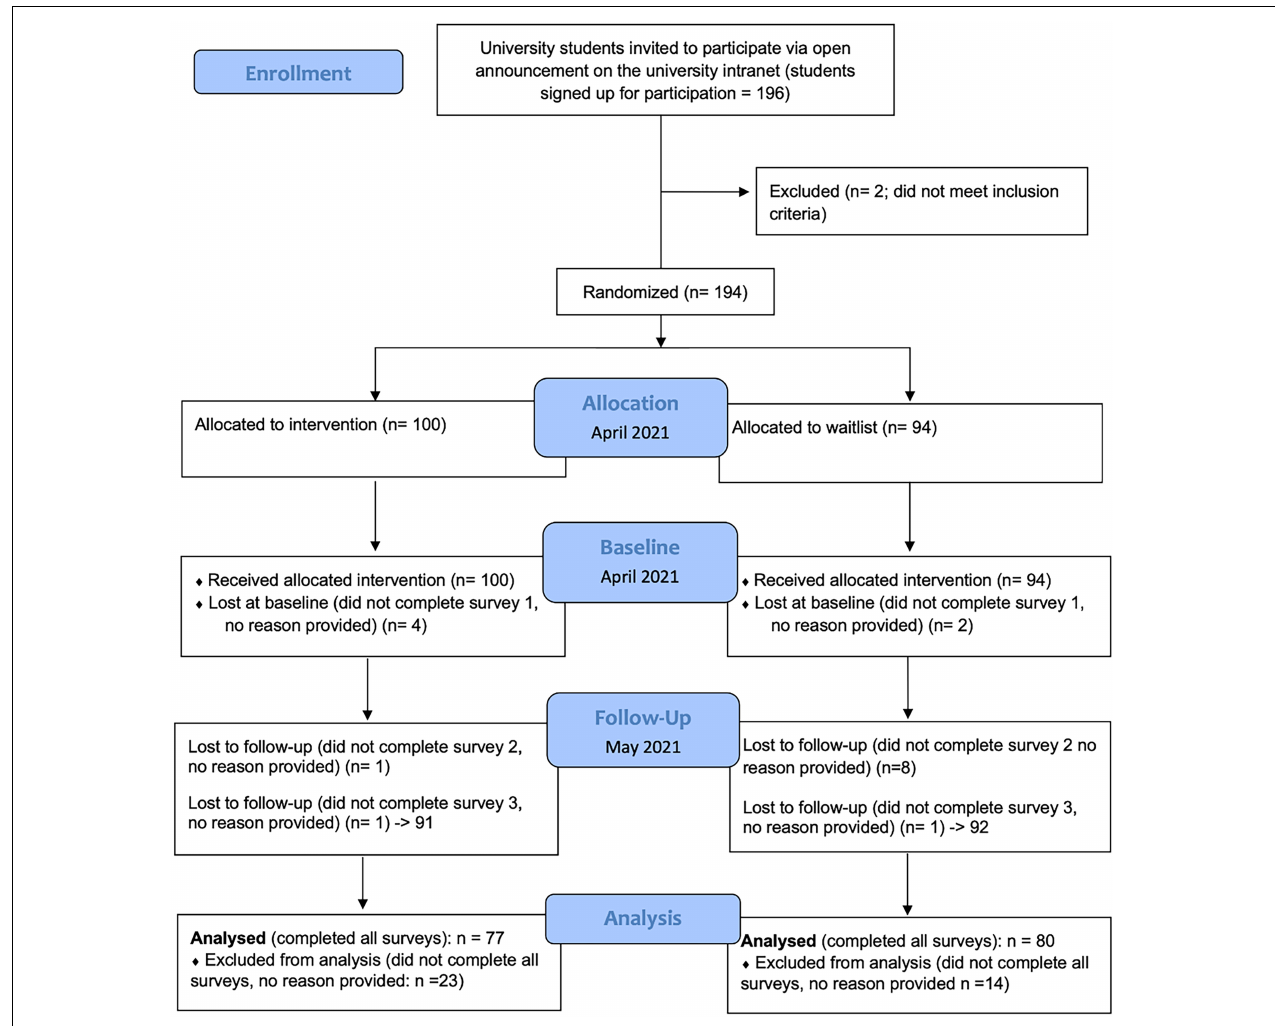
FIGURE 1 | Flow chart – timeline and procedure of current